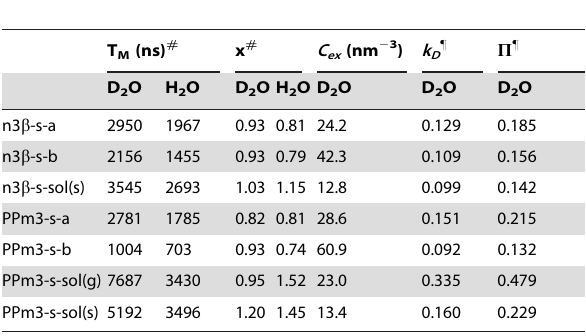
Table 1. Parameters obtained in the analyses of the ESE and ESEEM data. 1